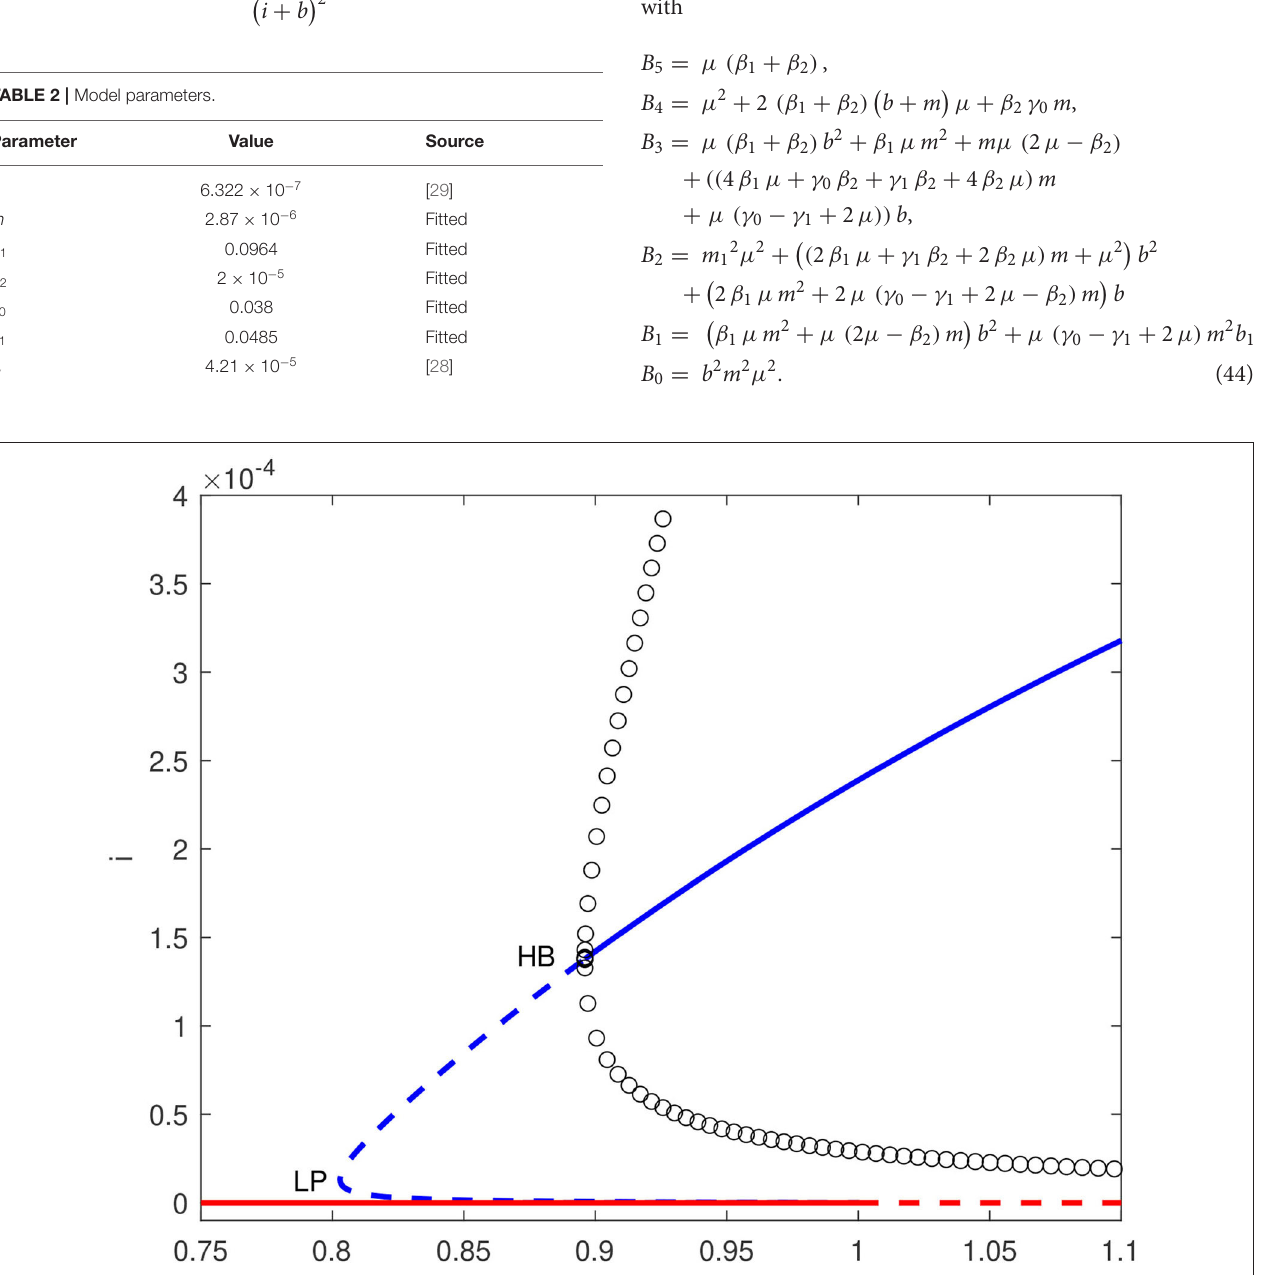
Frontiers in Physics |